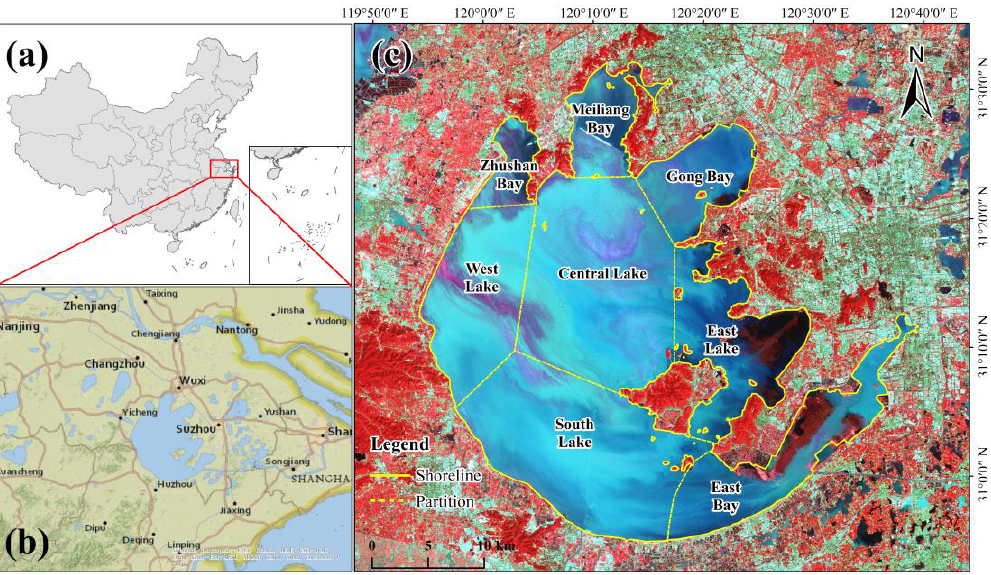
Figure 1. Map of the study area. ( a ) Map of China; ( b ) Taihu Basin; ( c ) Taihu Lake, Landsat OLI imagery on 21 September 2021, R:G:B = band 5:4:3.